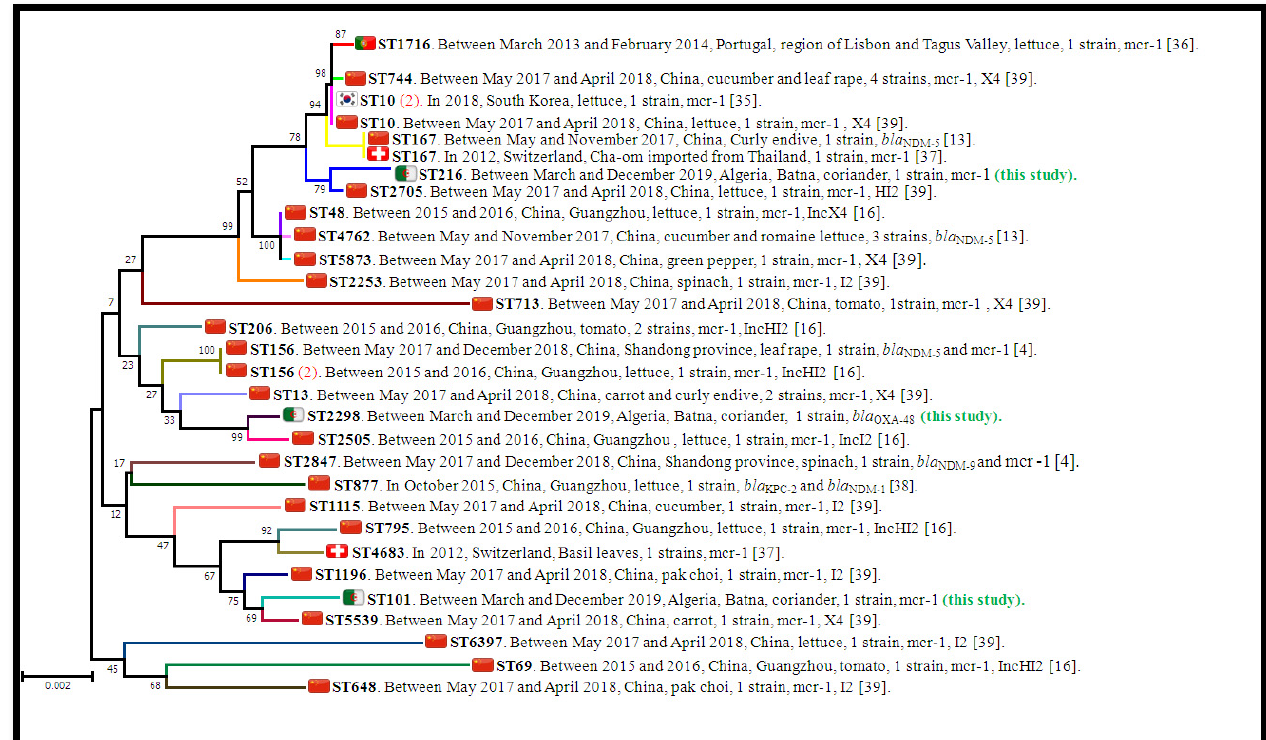
Figure 3. MLST concatenated gene-sequence-based phylogenetic tree of our carbapenemase or mcr - producing E. coli isolates with those positive for carbapenemase or mcr genes occurring worldwide from vegetables. The phylogenetic tree was built using Mega 7 software with the neighbour-joining method and evolutionary distances were computed using the Kimura two-parameter method. The number above the nodes is the bootstrap level from 1000 replicates. All sequence types are presented with their relative data (study period, country, source, strain number, drug resistance determinants with the described mobile